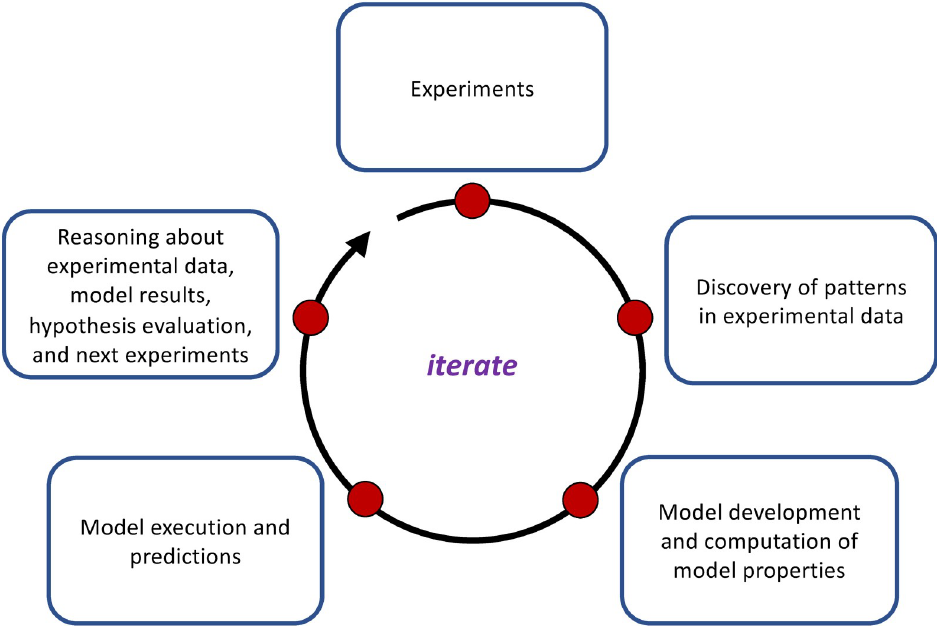
Fig 1. A representation of the steps in iterative abductive analysis. The process begins with conducting experiments and flows clockwise through reasoning about data and what experiments to perform next, whereupon the process repeats. Deductive analyses include these steps, but modeling occurs before experiments, so that the steps are rearranged. Parts of many of these steps (e.g., computing model properties) can be automated, and this automation is the focus of this paper. Other steps are not automated, such as the process of developing a model, because this requires a significant element of human reasoning. Thus, our software system requires human-in-the-loop execution. The process can be used in a purely experimental approach (i.e., no modeling). See the text for a description of this graphic.